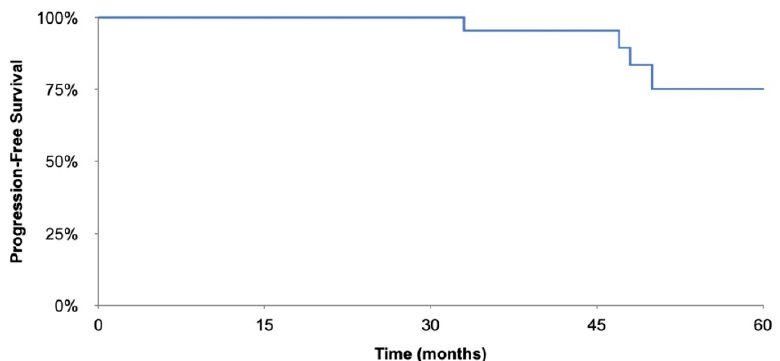
Figure 1. Kaplan–Meier progression-free survival curve.